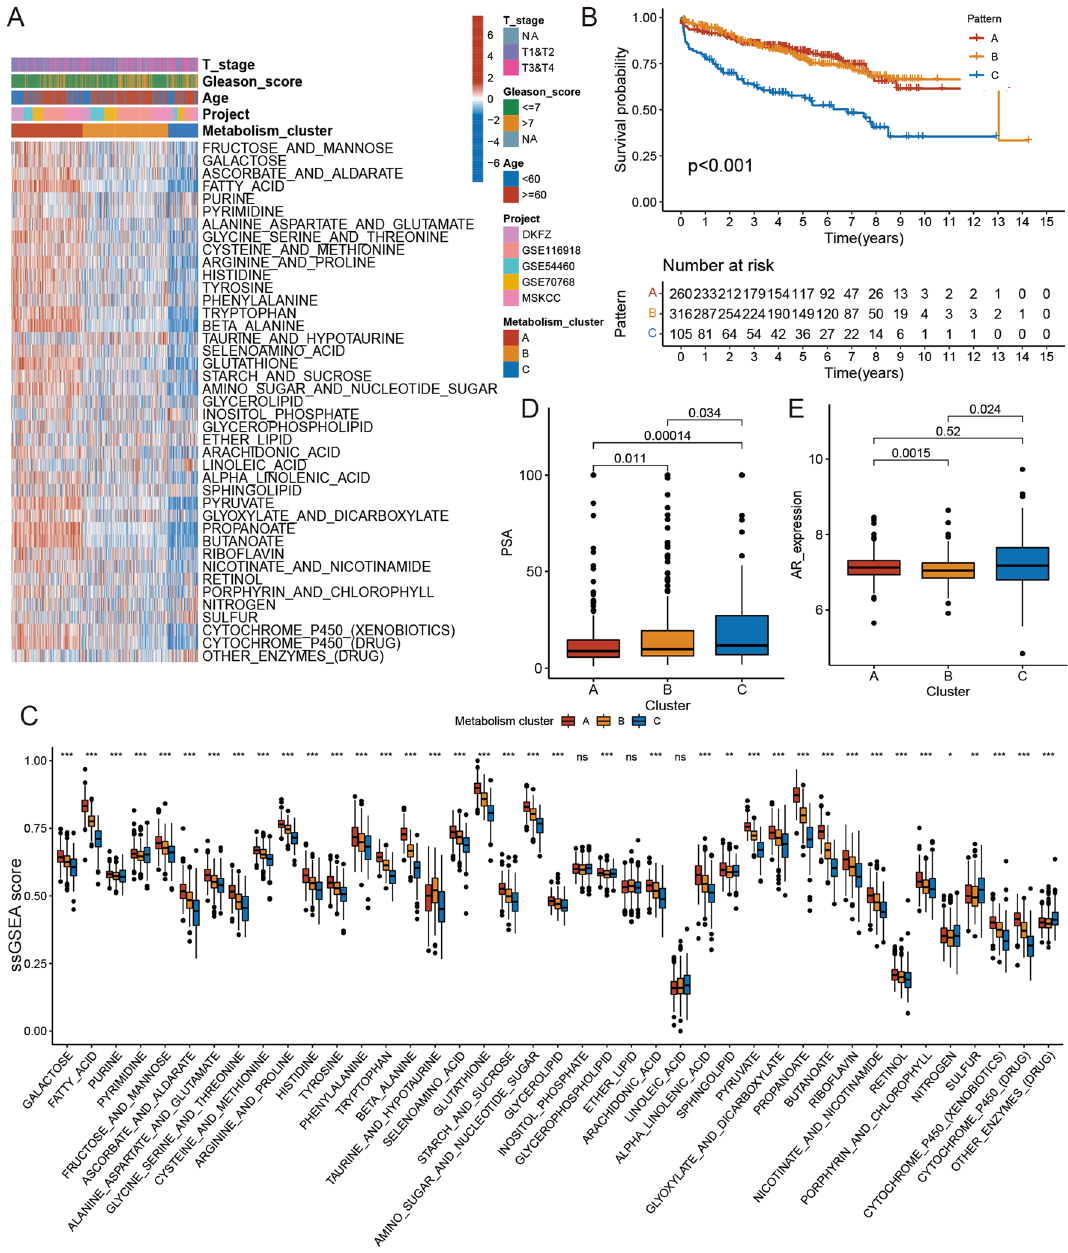
Figure 1. The landscape of active level of 41 metabolic pathways in PCa. ( A ) Unsupervised clustering of metabolic ssGSEA scores in five independent PCa cohorts. Rows represent tumor metabolic ssGSEA scores, and columns represent samples. ( B ) Kaplan–Meier curves for disease-free survival (DFS) of all PCa patients with metabolism clusters. The log-rank test showed an overall p < 0.001. ( C ) The metabolic ssGSEA scores in four metabolism clusters. The difference in PSA ( D ) and AR expression ( E ) among distinct metabolism clusters. The statistical difference of three metabolism clusters was compared through the Kruskal–Wallis test. * p < 0.05; ** p < 0.01; *** p <